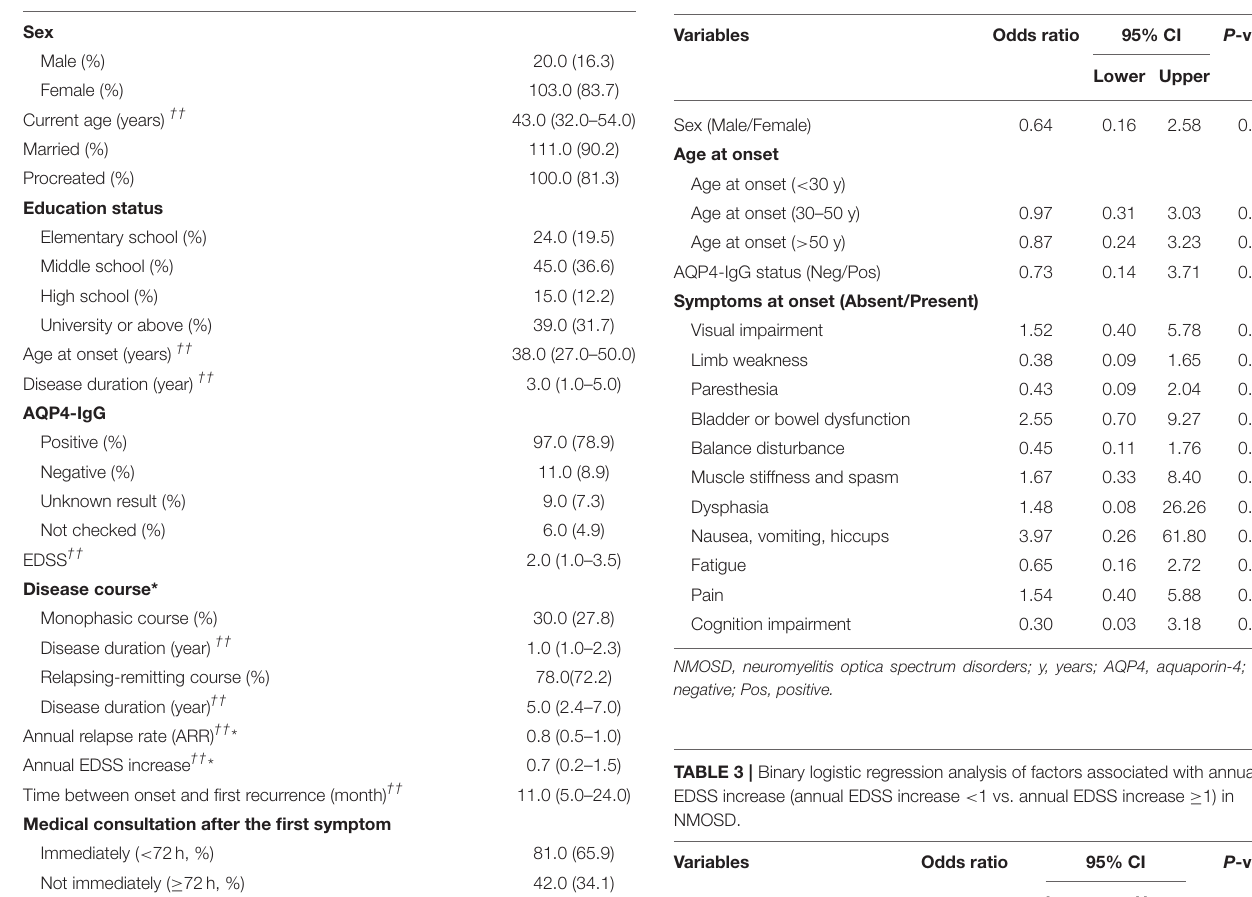
TABLE 2 | Binary logistic regression analysis of factors associated with disease course (Monophasic course vs. Recurrent course) in NMOSD.